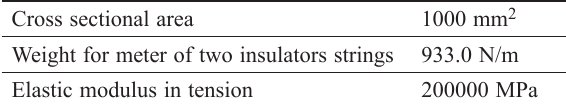
Table 5. Properties of insulator strings Cross sectional area Weight for meter of two insulators